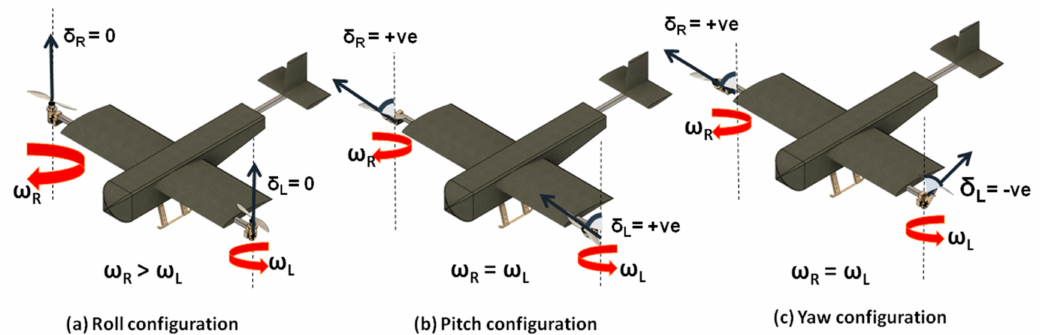
Figure 4. Isometric view of tilt-rotor during yaw, roll, and pitch in the VTOL flight phase. Here, ( a ) depicts the roll configuration due to differential thrust, ( b ) depicts the pitch configuration due to tilting of the motor-pod and ( c ) illustrates yaw due to tilting of the motor-pod in opposite directions.